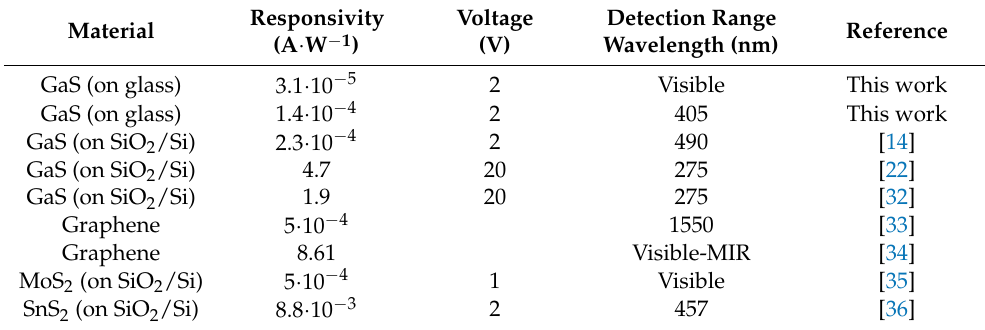
Table 1. Responsivity in typical low-dimensional photodetectors with experimental conditions.